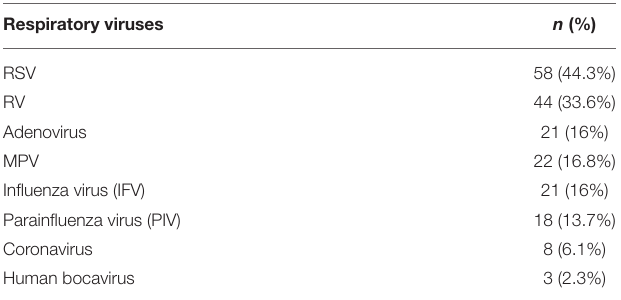
TABLE 2 | Absolute frequencies of viruses detected in nasopharyngeal washes of infants with bronchiolitis. Respiratory